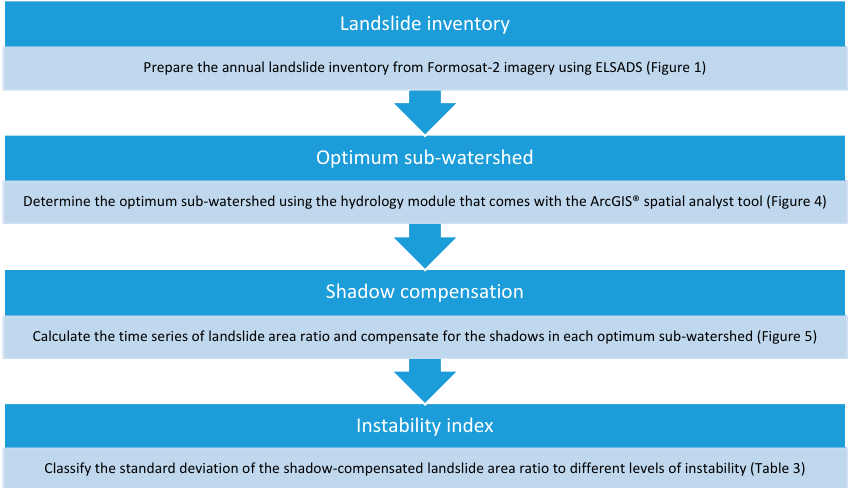
Figure 7. Computational flowchart revealing the steps for calculating the proposed instability index.